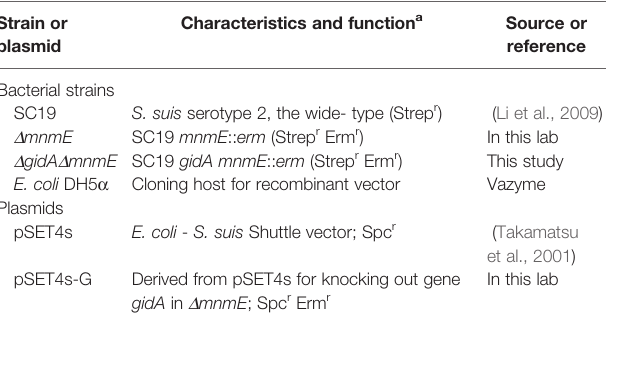
TABLE 1 | Bacterial strains and plasmid used in this study.